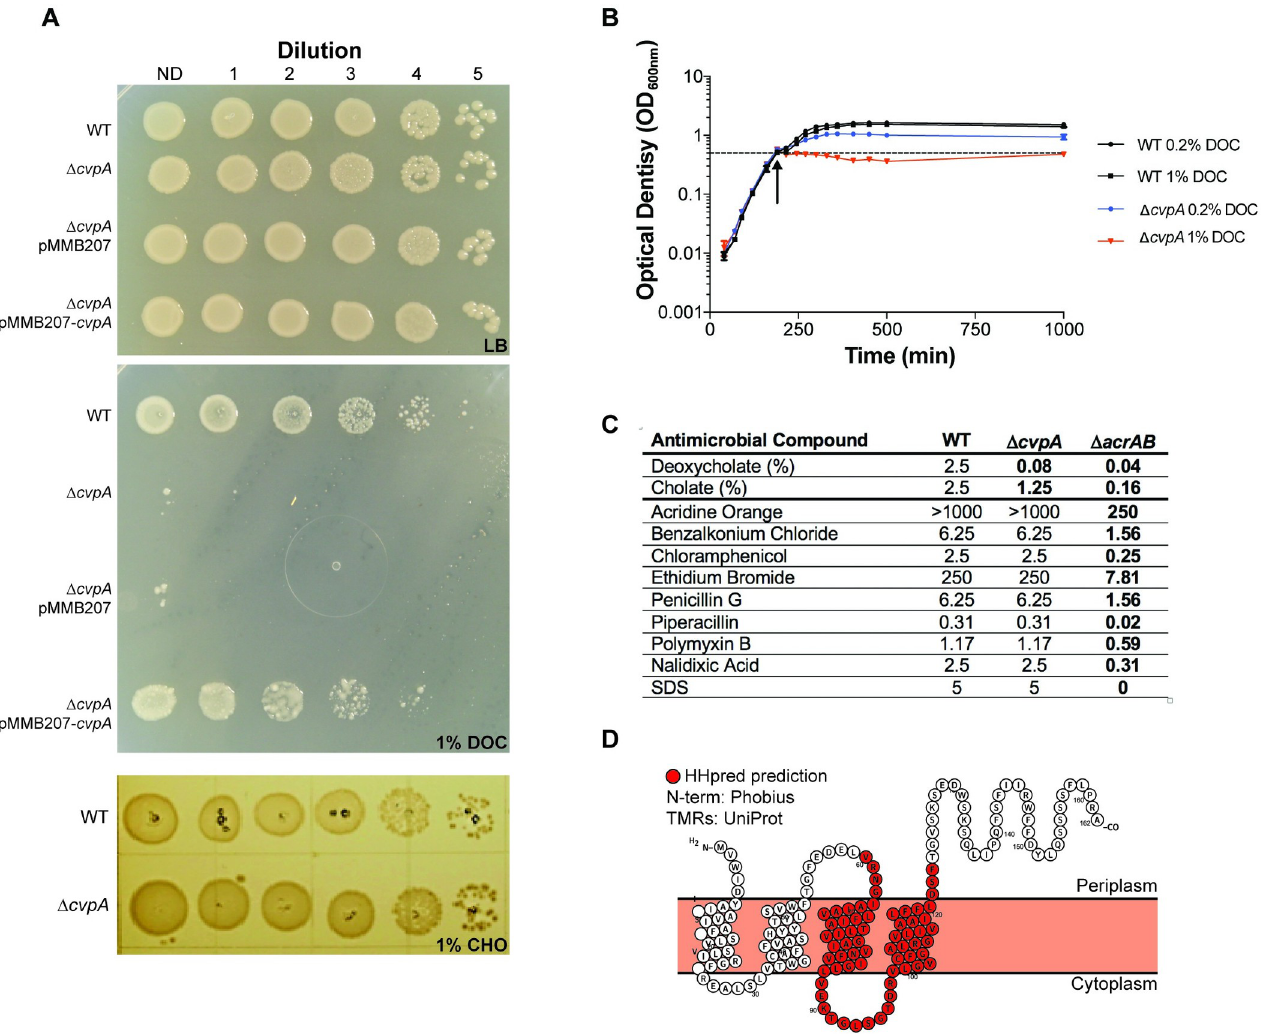
Fig 7. CvpA promotes EHEC resistance to deoxycholate. (A) Dilution series of WT, Δ cvpA mutant, and Δ cvpA mutant with arabinose-inducible cvpA complementation plasmid plated on LB, LB 1% cholate (CHO) or LB 1% deoxycholate (DOC). (B) Optical density of WT and Δ cvpA grown in LB and two concentrations of DOC, added at the indicated arrow. The average of three readings is plotted with errors bars indicating standard deviation. (C) MIC of antimicrobial compounds for WT and Δ cvpA and Δ acrAB mutants. Units are mg/mL unless specified otherwise. Bolded values are those different than the wild- type. (D) Schematic of predicted CvpA